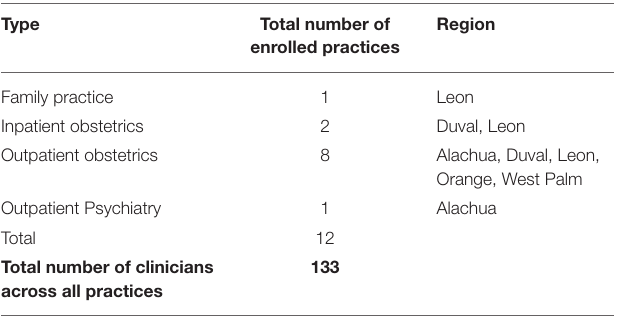
TABLE 3 | Encounters according to provider type and encounter type from September 26, 2019 to June 30,